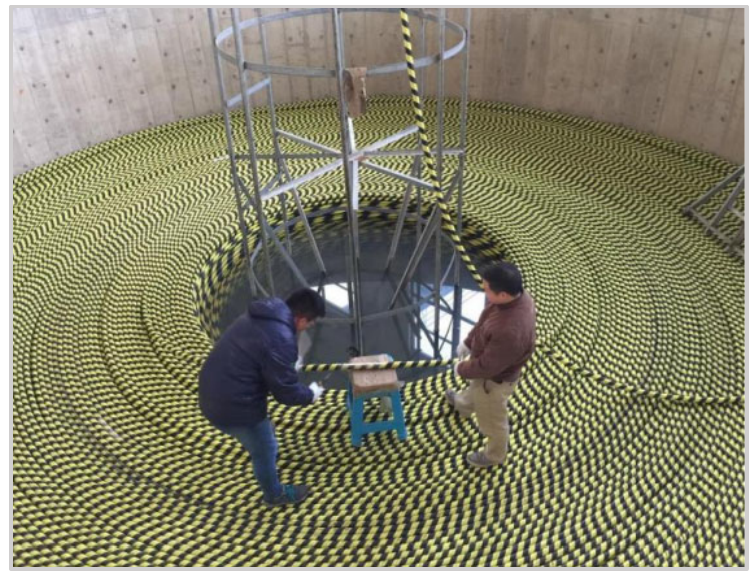
Figure 5. Online submarine cable monitoring system using bidirectional MZ interferometer. Reprinted with permission from [81].